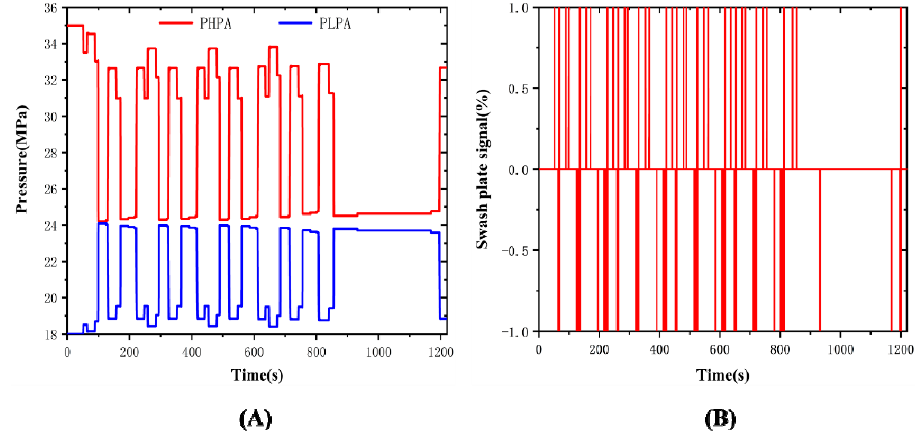
Figure 7. ( A ) Accumulator pressure change curve; ( B ) Swashplate signals change curve.